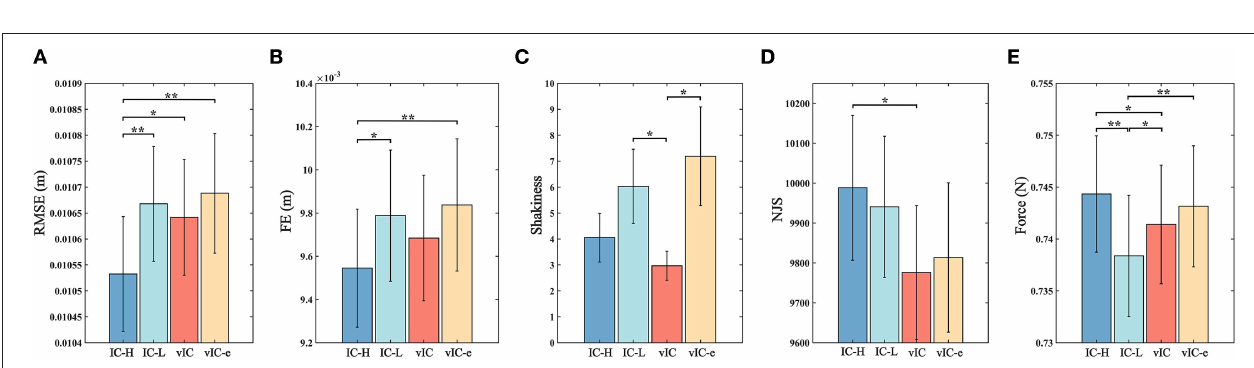
FIGURE 10 | The analysis parameters of four control algorithms for a reaching task. Average parameter for the four point-to-point tracking subtasks (mean ± SE). (A) Statistical results of the root mean square error (RMSE) for all subjects. (B) Statistical results of four control algorithms expressed the final error (FE). (C) Analysis of the shakiness. (D) Analysis of the normalized jerk score (NJS). (E) Analysis of the mean output force in the experiments. *Indicates significant difference between two control algorithms at 0.05 level; and **Indicates significant difference between two control algorithms at 0.01